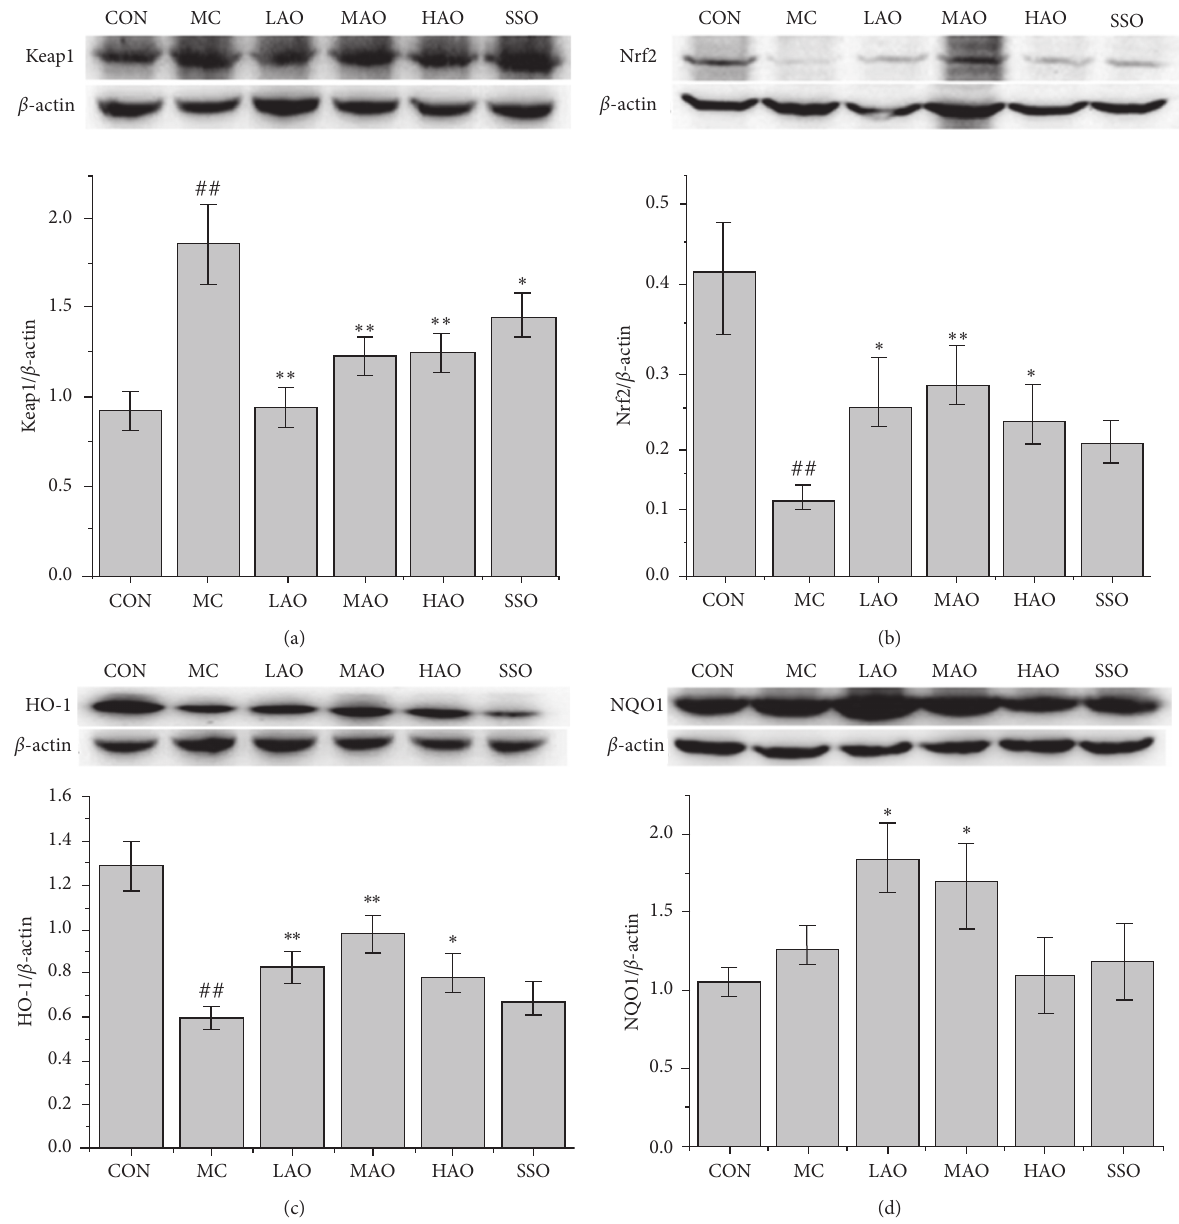
Figure 7: Effects of almond oil on Nrf2/HO-1 pathway in STZ-induced rats. Data are Western blotting results and gradation analysis of Keap1 (a), Nrf2 (b), HO-1 (c), and NQO1 (d). Data were expressed as means ± SD. The MC group compared with the CON group, # P < 0 . 05, ## P < 0 . 01; the LAO, MAO, HAO, and SSO groups compared with the MC group, ∗ P < 0 . 05, ∗∗ P < 0 .